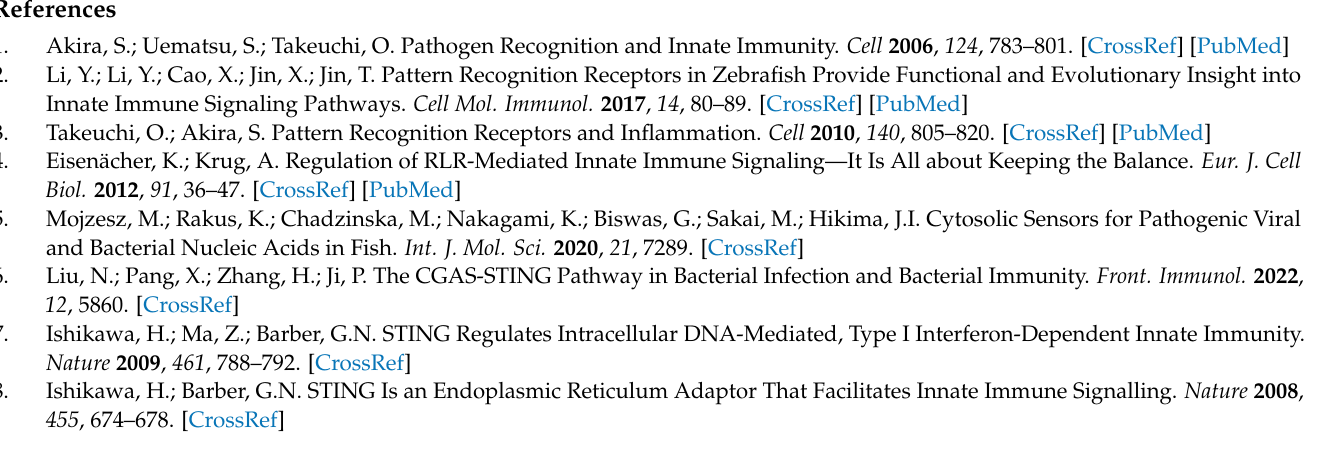
developmental stages. Figure S2A: The experimental flowchart of E. piscicida infection; Figure S2B: PCR confirmation of E. piscicida infection at 6